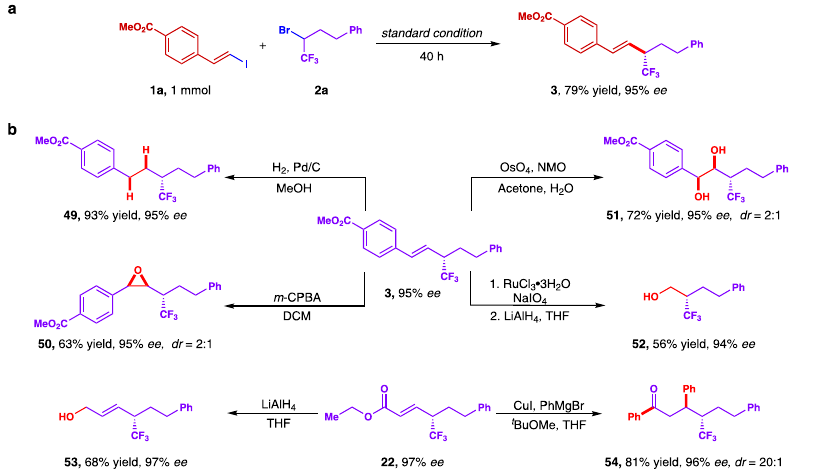
Fig. 3 | Synthetic utility. a 1mmol scale reaction. b Synthesis of diverse tri fl uoromethylated chiral